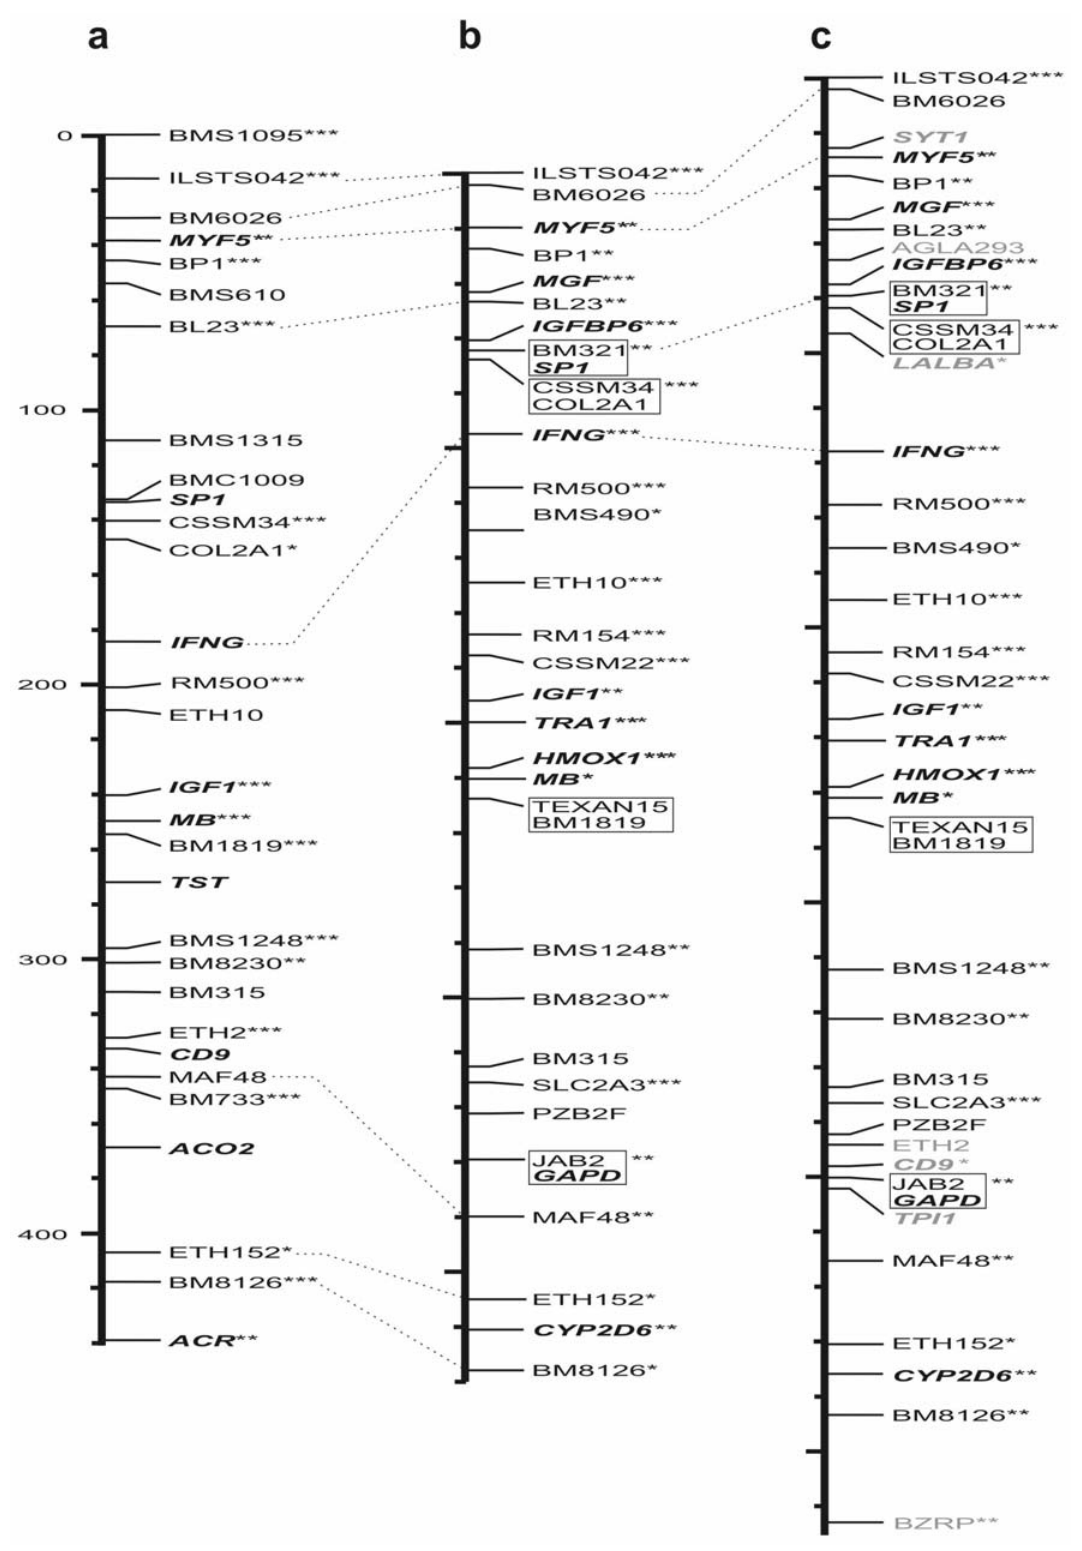
Figure1 -RadiationhybridmapofBTA5.a)UpdatedversionoftheBand etal .(2000)mapshowing30ofthe85markers(http://cagst.animal.uiuc.edu). b) Comprehensive map showing the most likely order, using the program RHMAP 3.0. c) Comprehensive map including 7 of the makers scored by Barendse et al . (2000, shown in gray). Map increments are 20 cR 5,000 . Boldfaced-italicized markers are near or within coding sequences. Markers with *, ** and *** were ordered with LOD supports of at least 1.0, 2.0 and 3.0, respectively. Dashed lines indicate regions with larger or smaller distances than the comprehensive map in